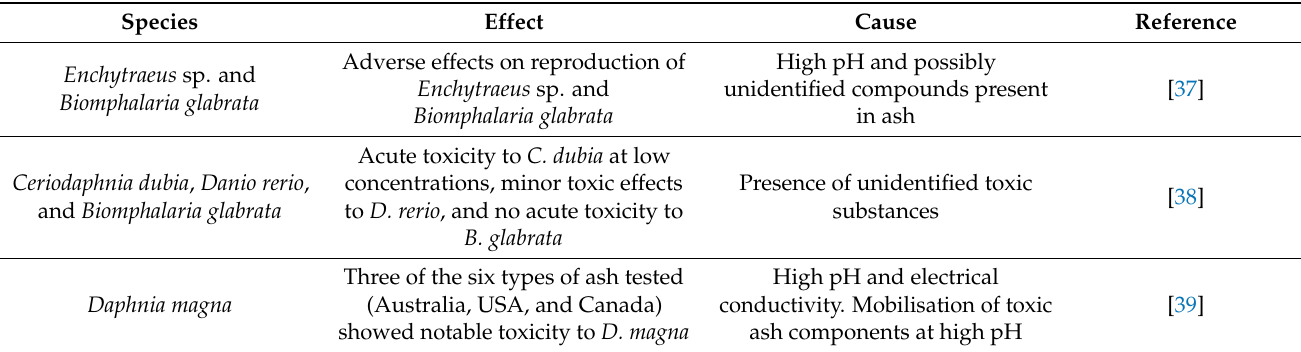
Table 3. Effects of ash on other soil and aquatic